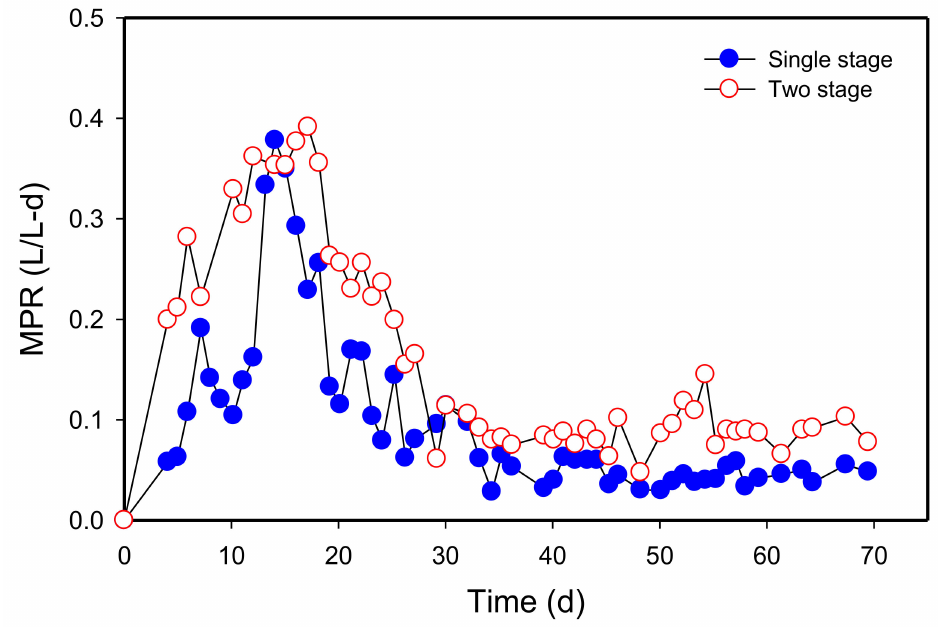
Figure 4. Methane production rate at two-stage and single-stage